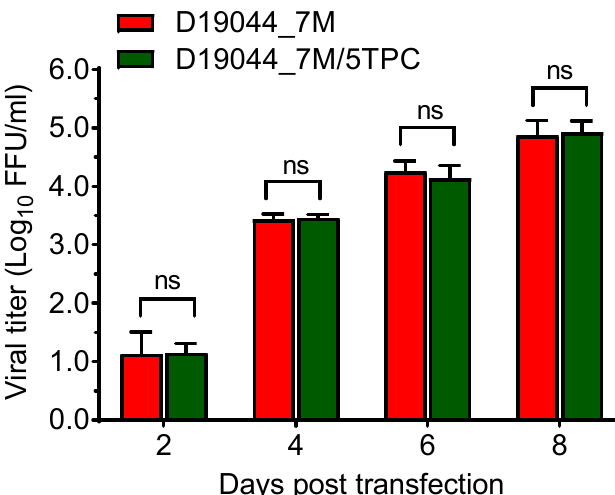
Figure 4. D19044_7M clone were genetically stable in the transformant bacteria. D19044_7M clone plasmid that have gone through five rounds of transformation-purification cycle (5TPC) produced infectious virus comparable to D19044_7M clone. The viral titers were determined by FFU assay. The means ± SEM of three independent experiments are shown. Statistics analysis were performed using multiple comparison test in a two-way ANOVA. ns, no significance.